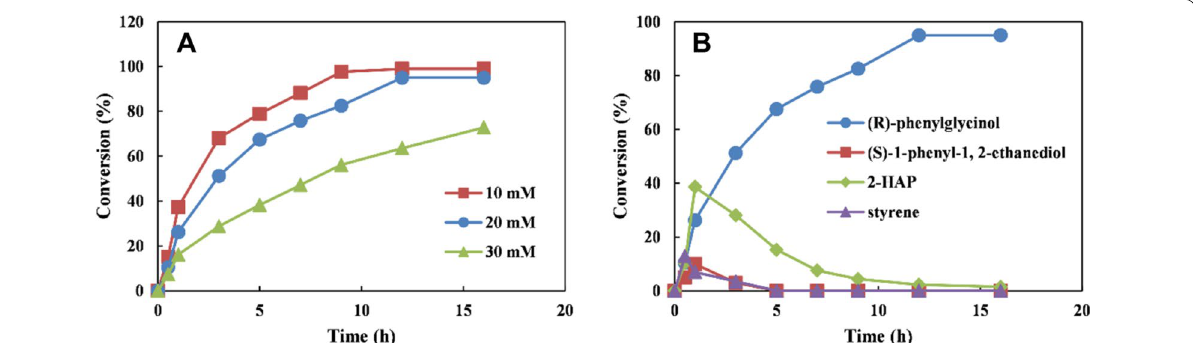
Fig. 7 Time course of the cascade reaction for the synthesis of ( R )-7 from L-PA 1. A Time course of the cascade reaction for conversion of 10–30 mM L-PA to ( R )- 7 ; B time course of the cascade reaction for intermediate produced from L-PA 1 . Reaction conditions (5 mL): 100 mM phosphate buffer (pH 7.5), 10–30 mM L-PA, 20 mM glucose, 15 g cdw/L E. coli (RFP-DEA-CGS), 20 g cdw/L E. coli (EB-DGA), 400 mM L-ala, 150 mM NH 3 /NH 4 Cl, 0.1 mM PLP, at 25 °C. All biotransformations were performed in duplicate and conversion was determined by GC, error limit: < 2% of the state values